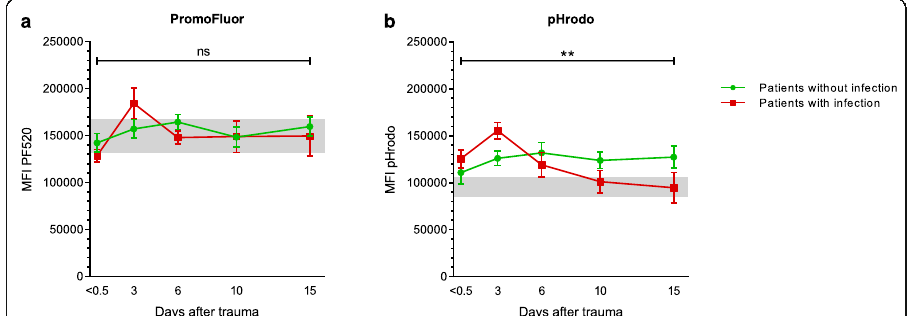
Fig. 3 PromoFluor and pHrodo fluorescence. Neutrophil PromoFluor ( a ) and pHrodo ( b ) fluorescence in patients who developed an infection (red square) and patients who did not develop an infection (green circle) after 60 min of incubation with S. aureus bioparticles. Patients with infections were compared to patients without infections with generalized estimating equations. Data are presented as mean with the standard error of the mean. Gray areas represent healthy control values (95% confidence interval). MFI = mean fluorescence intensity. PF520 = PromoFluor 520 LSS. S. aureus = Staphylococcus aureus. Ns = non- significant. ** p <